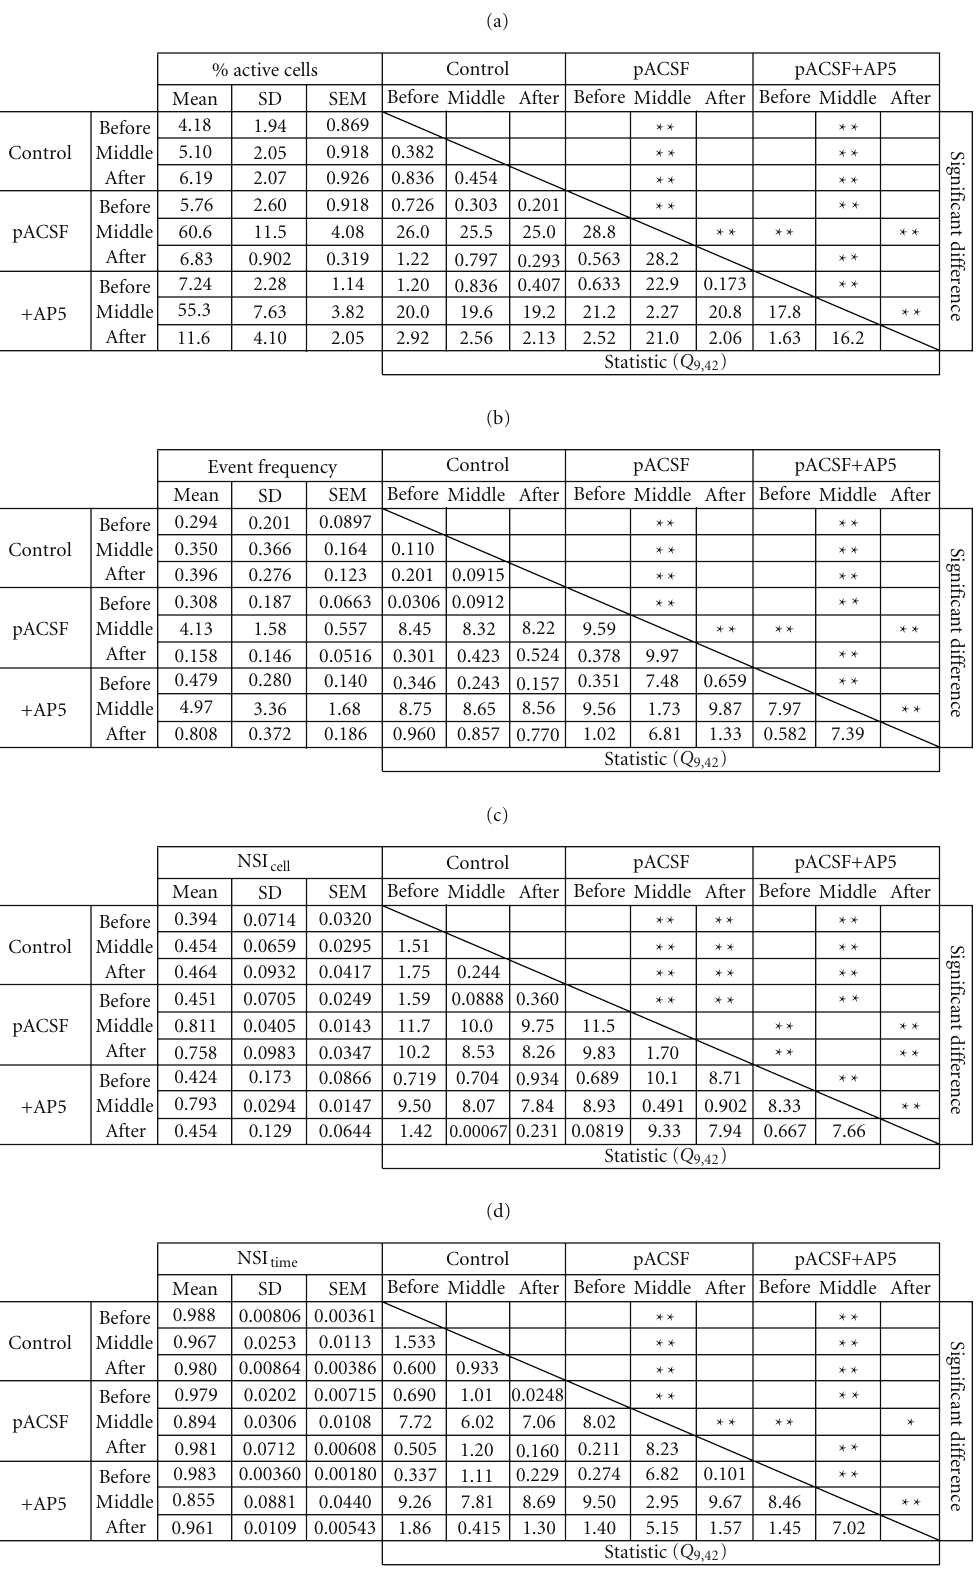
Table 1: Statistics of pACSF-induced plasticity of spontaneous network activity . The percentage of active cells (a), the mean event frequency (b), NSI cell (c), and NSI time (d) are shown as the average values from − 5 to 0 minute (before), from 10 to 15 minutes (middle), and from 20 to 25 minutes (after) after treatment of pACSF. (Control, N = 5; pACSF, N = 8; pACSF+AP5, N = 4). ∗ P < . 05, ∗∗ P < . 01 post-hoc Tukey-Kramer multiple comparison test after one-way